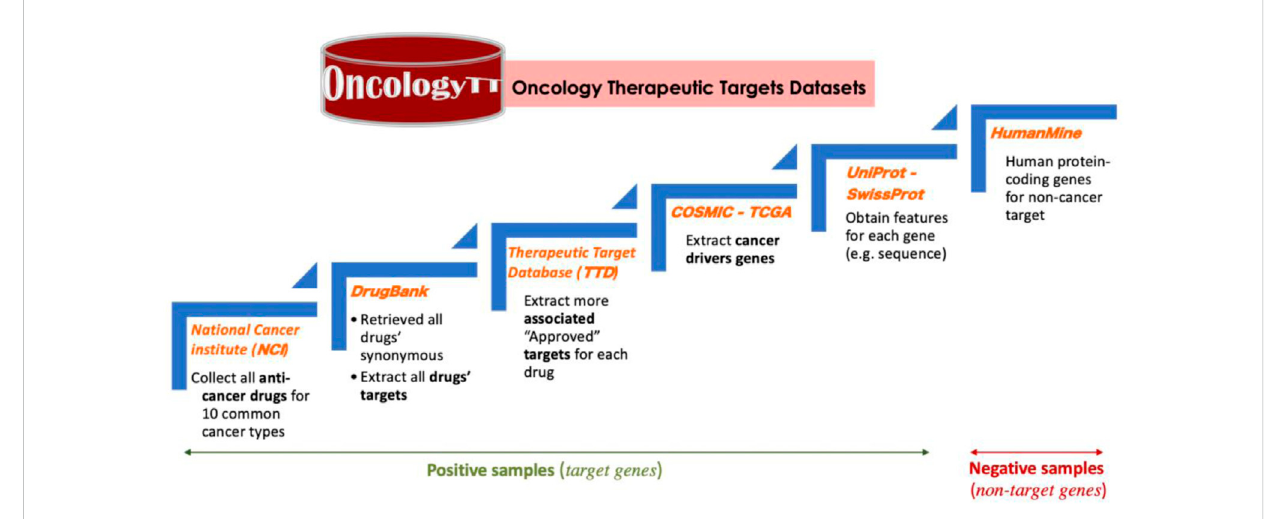
FIGURE 1 The steps implemented to create the OncologyTT